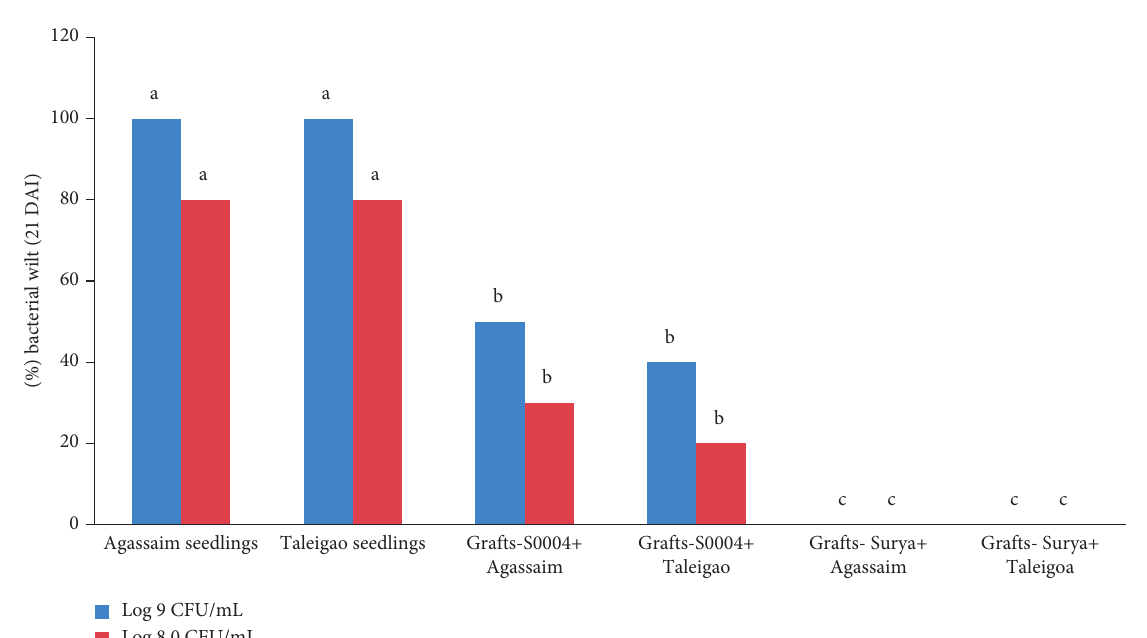
Figure 1: Incidence of bacterial wilt in eggplant grafts on S0004 and Surya in the greenhouse evaluation. % of plants wilted 21 days after the inoculation of R. pseudosolanacearum (8 Log CFU mL − 1 and 9 Log CFU mL − 1 ). Treatments are significantly different at 5% (LSD � 26.54). Wilt % in the column indicated by the same letter are not significantly different at 5%